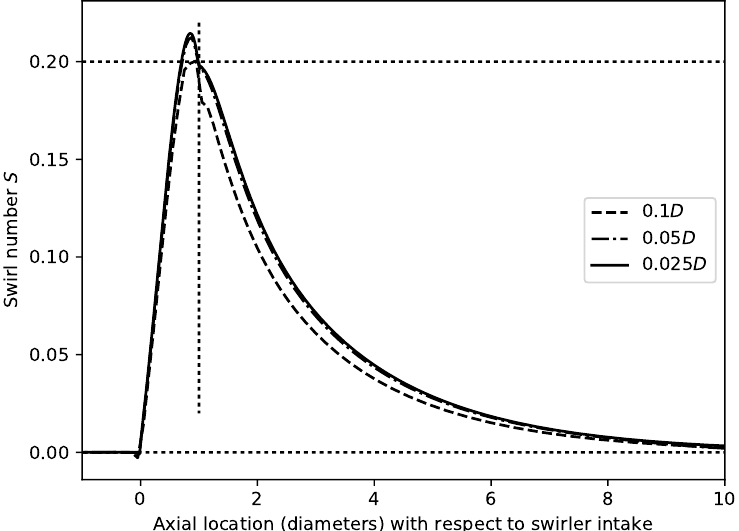
Figure 10. Change in swirl number along the pipe axis for three different mesh densities, calculated for Case I with a total twist of 180 ◦ . The vertical dotted line indicates the exit of the